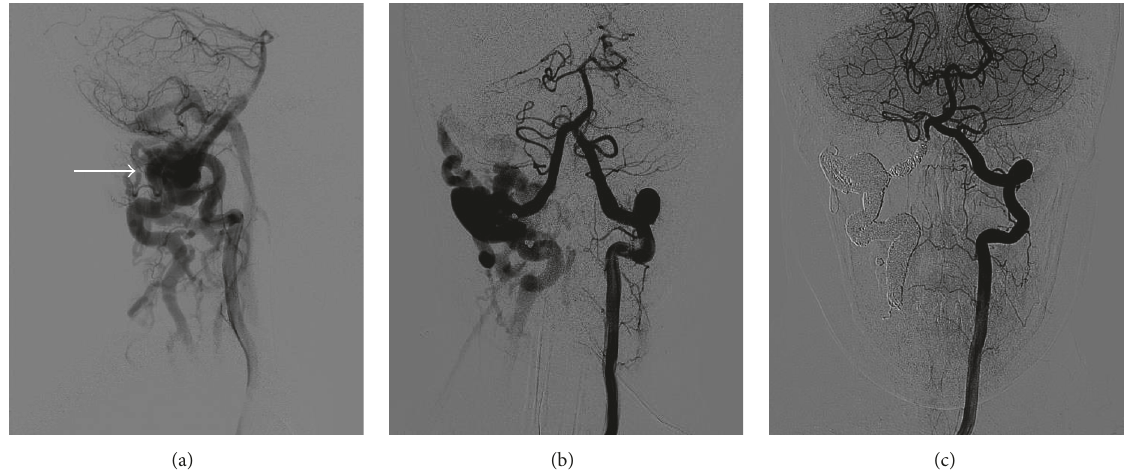
Figure 1: (a) and (b) Preoperative vertebral angiogram right anterior oblique (a) and anteroposterior (b) views showing an arteriovenous fistula (indicated by arrow) at the level of C1, with no obstruction of the left vertebral artery. (c) Postoperative vertebral angiogram anteroposterior view shows no evidence of